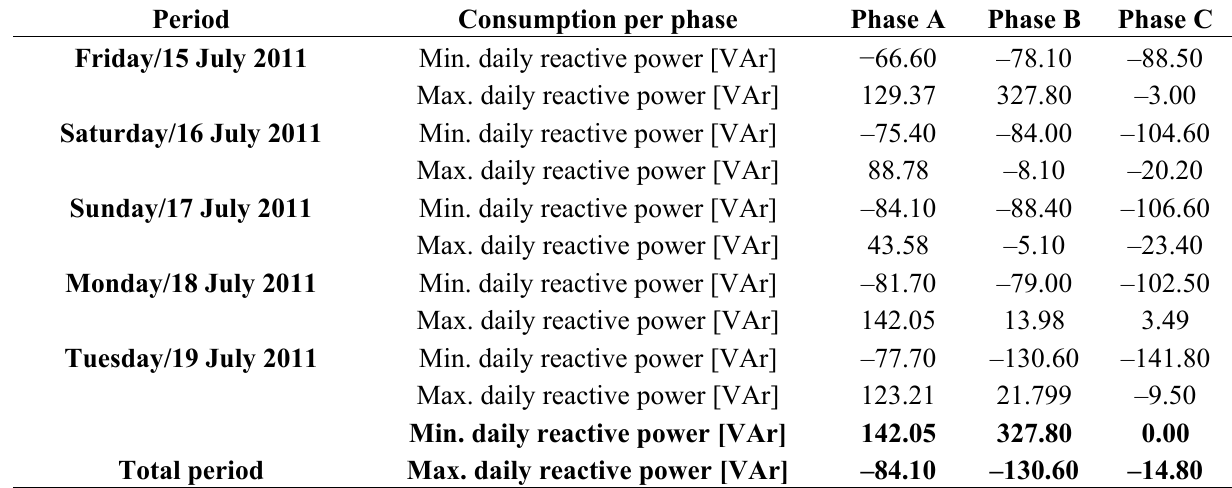
Table 6. Daily and total AC reactive power consumption